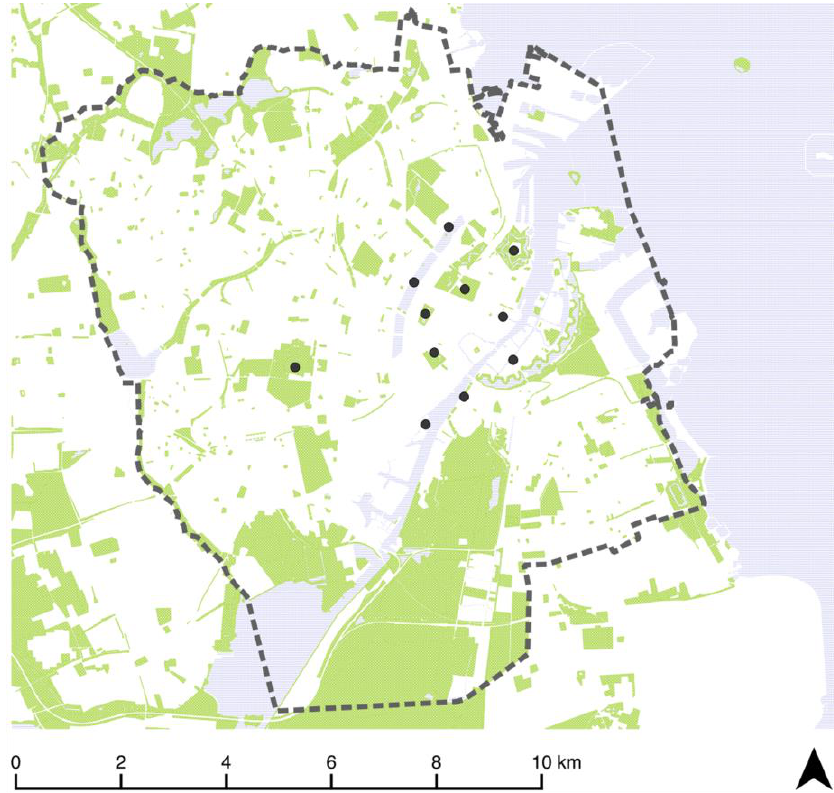
Figure 6. Top 11 Nature Hotspots relative to public green and blue